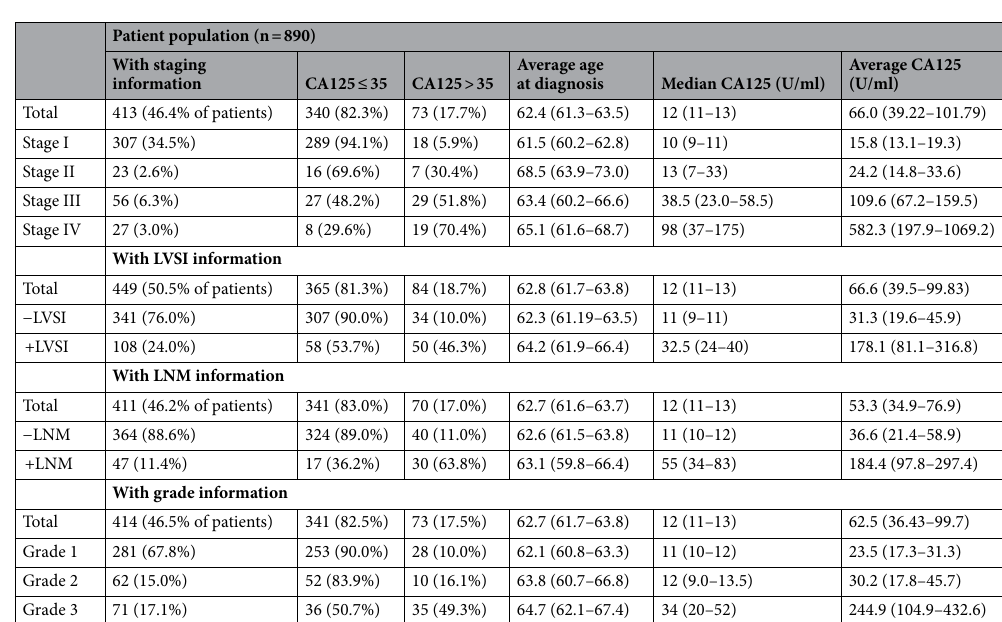
Patient population (n =